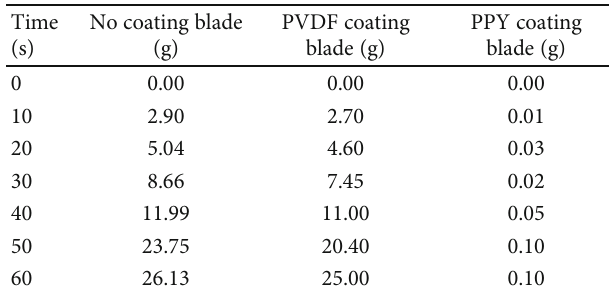
Figure 8: Contact angle and water droplet shape of wind turbine blade coated with PPy coating. Table 1: Variation of ice in three models.